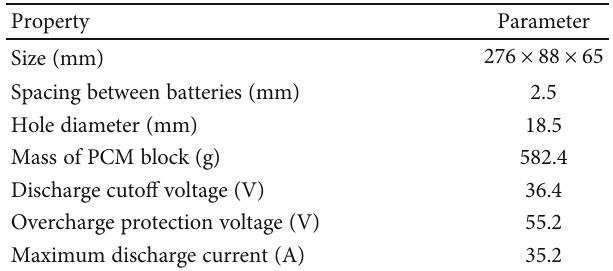
Table 1: Parameters of the battery